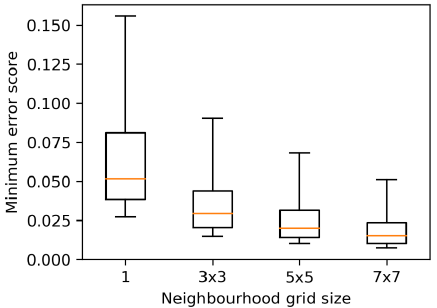
Figure 3. Box plots showing the distribution of the minimum er- ror score across stations in each neighbourhood grid size. The box represents 25–75th-quantile values, the horizontal line in the box represents the median, and whiskers represent 5–95th